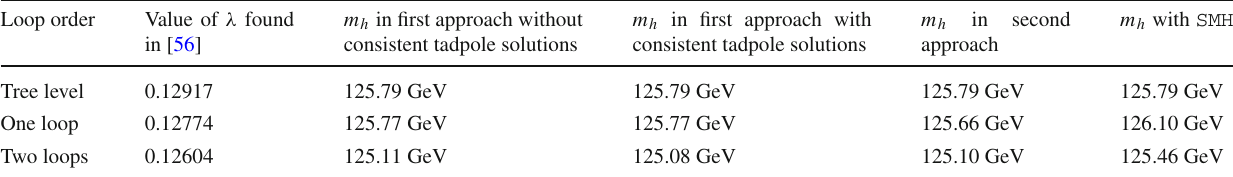
Table 1 Values of the Higgs mass at scale Q = m t for the values of the quartic couplings λ found in [56] at tree level, one loop and two loops, in the two approaches we used for SPheno and with SMH . The first approach was to change only the SM parameter inputs while letting SPheno determine the top-Yukawa and electroweak gauge couplings, and the Higgs mass is computed both with and without the consistent tadpole solutions. The second method was to take the same values of